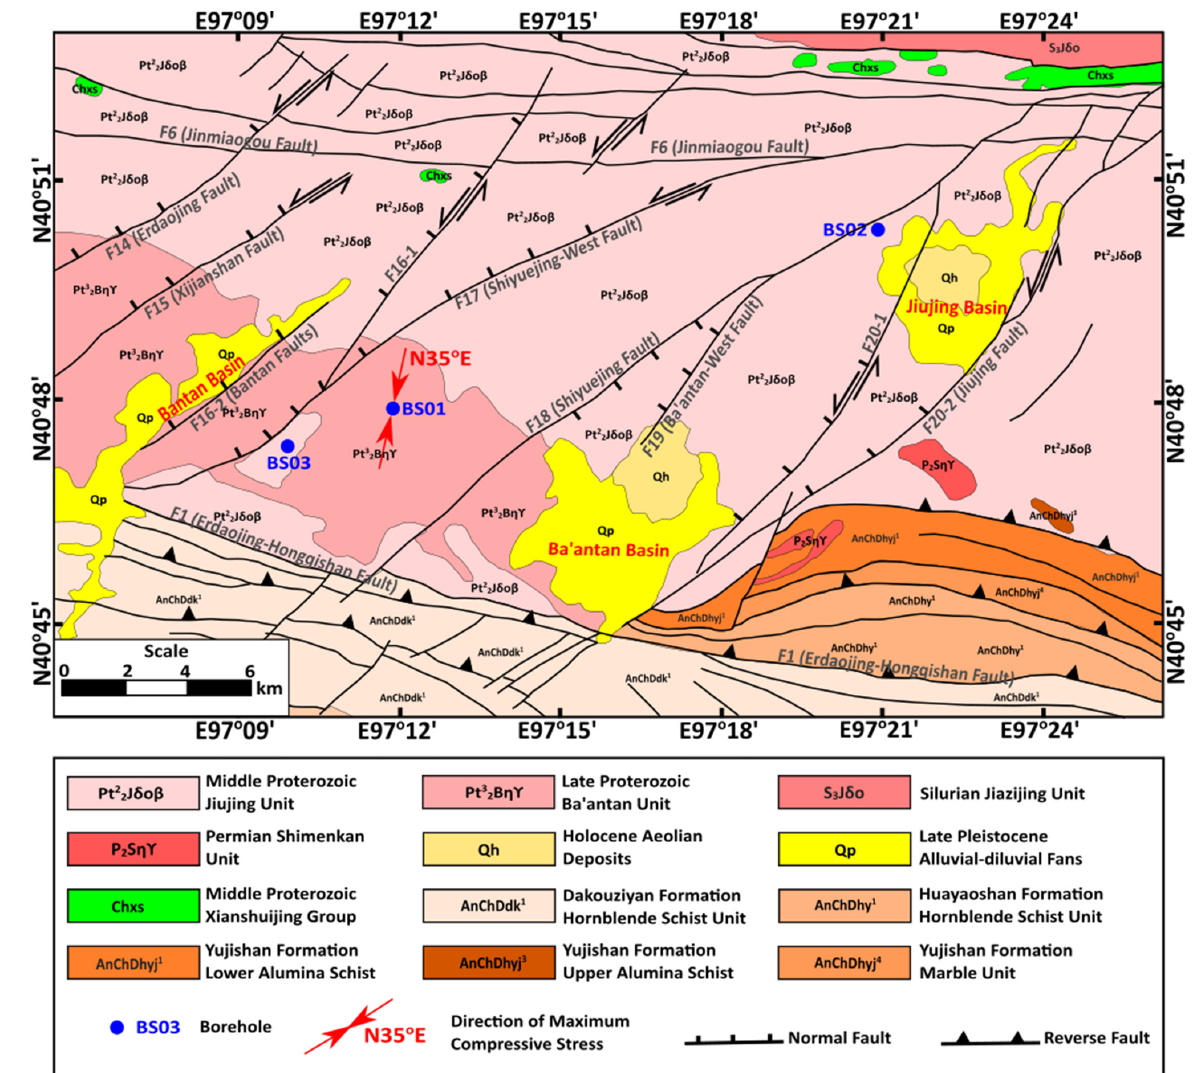
Figure 3. The map of the Jiujing granite region shows the distribution of faults, Quaternary sedi- ments, exposed formations, and the granite, where BS01, BS02, and BS03 refer to borehole number. Information is summarised from literature [21,22].